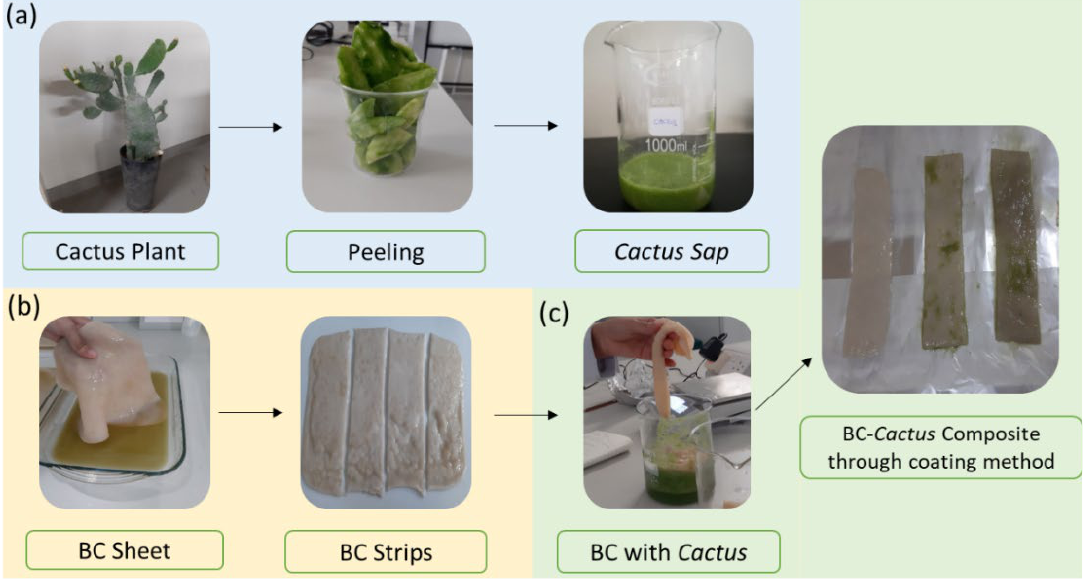
Figure 1. Different steps for the preparation of ( a ) cactus sap, ( b ) BC strips and ( c ) BCC composite.